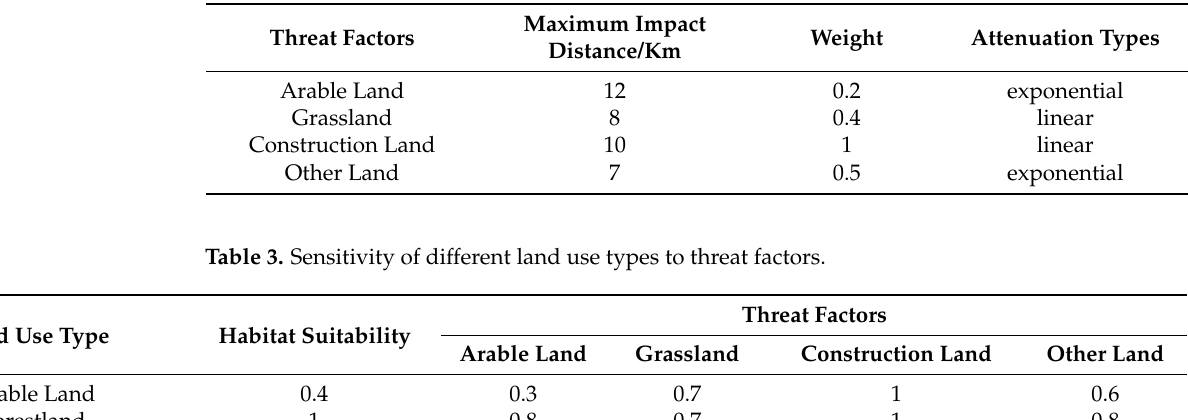
Table 2. Threat factors and their maximum impact distance, weight, and attenuation types.